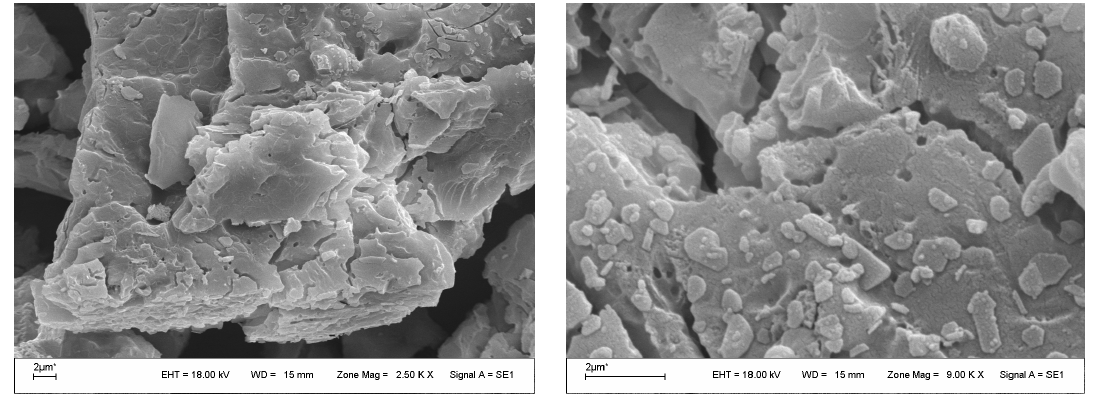
Figure 6. XRD of the leaching residues ( X : 0.2; time: 1 min; and temperature: 308 K).